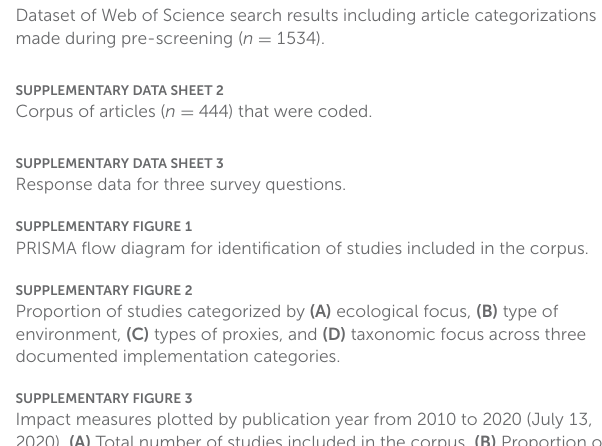
SUPPLEMENTARYDATASHEET3 Response data for three survey